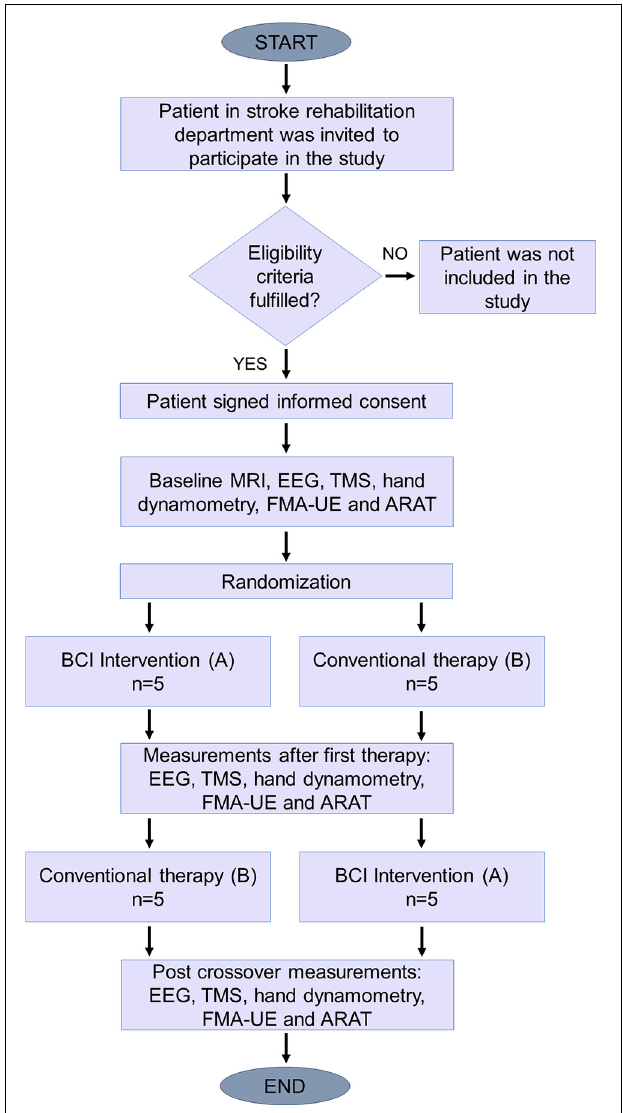
FIGURE 2 | Study design diagram. After eligibility criteria were assessed, patients were assigned randomly to one of the two sequences.